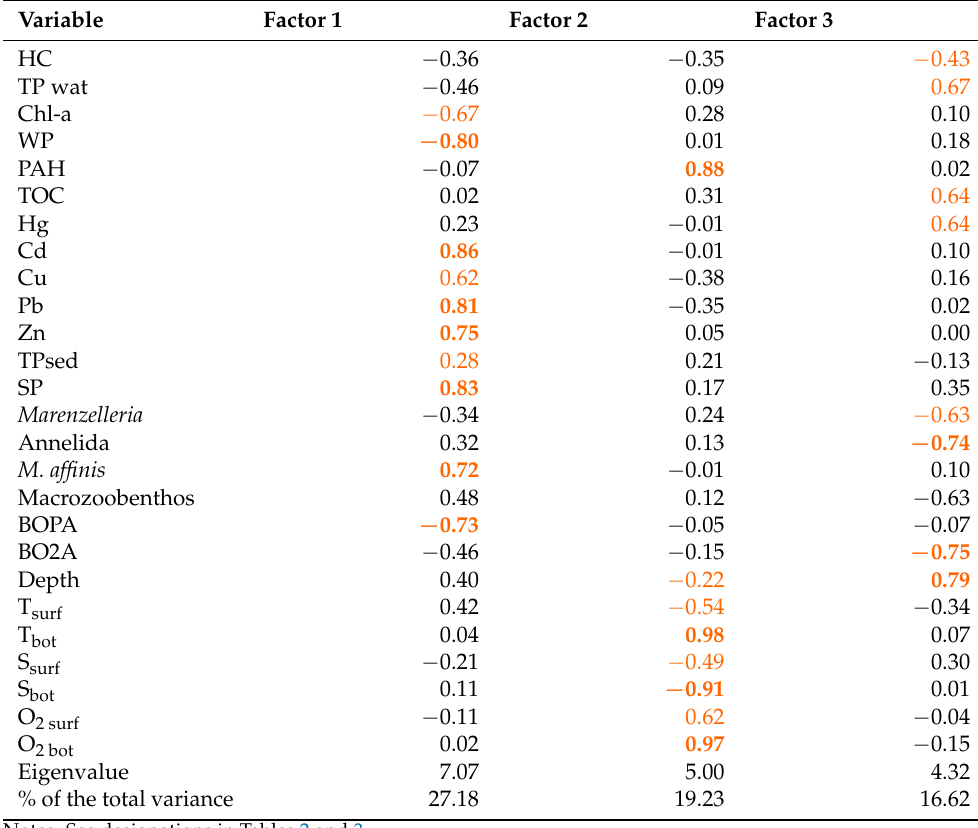
Table 4. Factor loadings for the Principal components, significant loadings are >0.70, they are marked in bold. The red color shows variables that form clusters determining the oblique factors for hierarchical